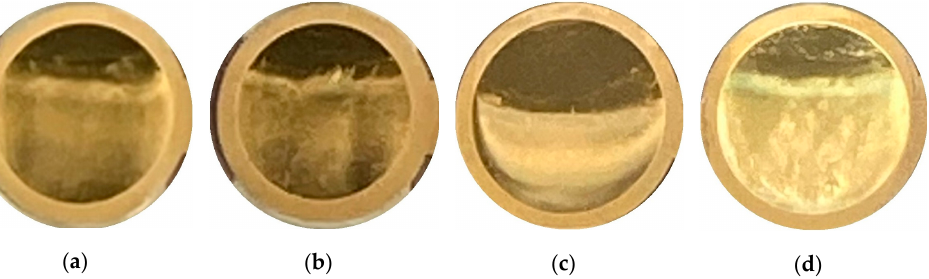
Figure 7. Pictures of the sensor active surfaces where biofilms were adhered to in the experiments: ( a ) channel 2 of the 24-h experiment, ( b ) channel 4 of the 24-h experiment, ( c ) channel 1 of the 48-h experiment, and ( d ) channel 9 of the 48-h experiment.